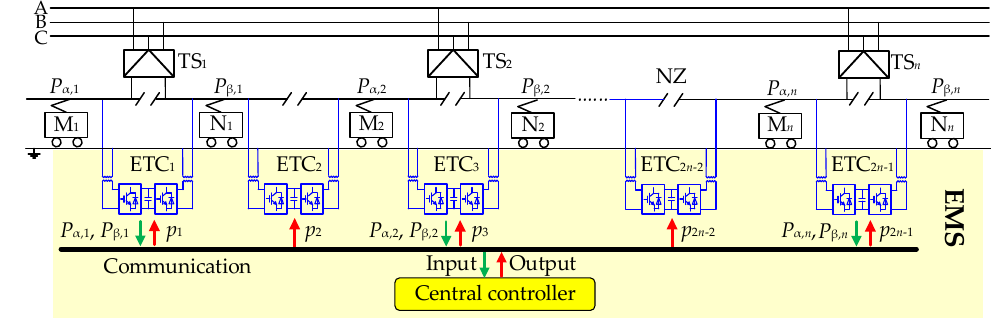
Figure 3. Railway power supply system with an energy management system (EMS).